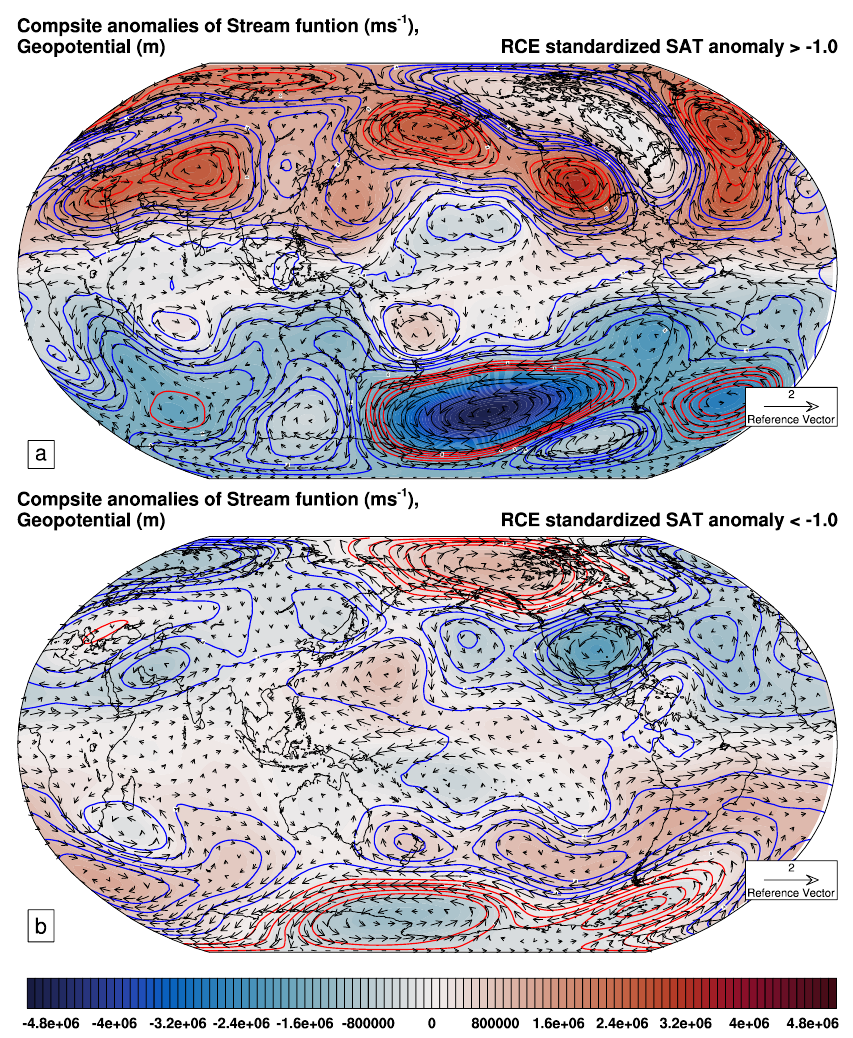
Figure A5. For the sustained RRM simulations: ( a ) composite anomalies of the stream function (ms − 1 , shaded), wind vector (ms − 1 ) and geopotential height (m, red contours are for positive and blue contours for negative anomalies) at 200hPa for conditions in which the standardized SAT in the RRM region greater than − 1.0K; and ( b ) the sam as ( a ), but for conditions in which the standardized SAT in the RRM region is less than −